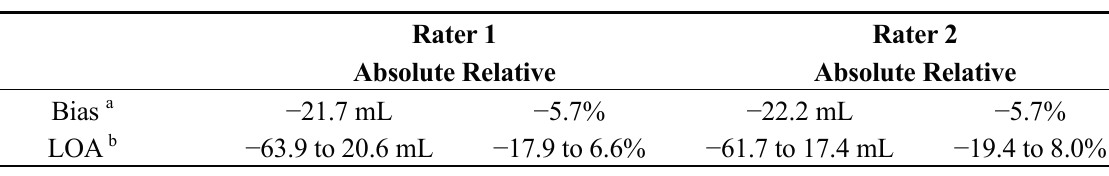
Table 2. Accuracy of SkanLab in measuring inanimate objects (cylinders; N =